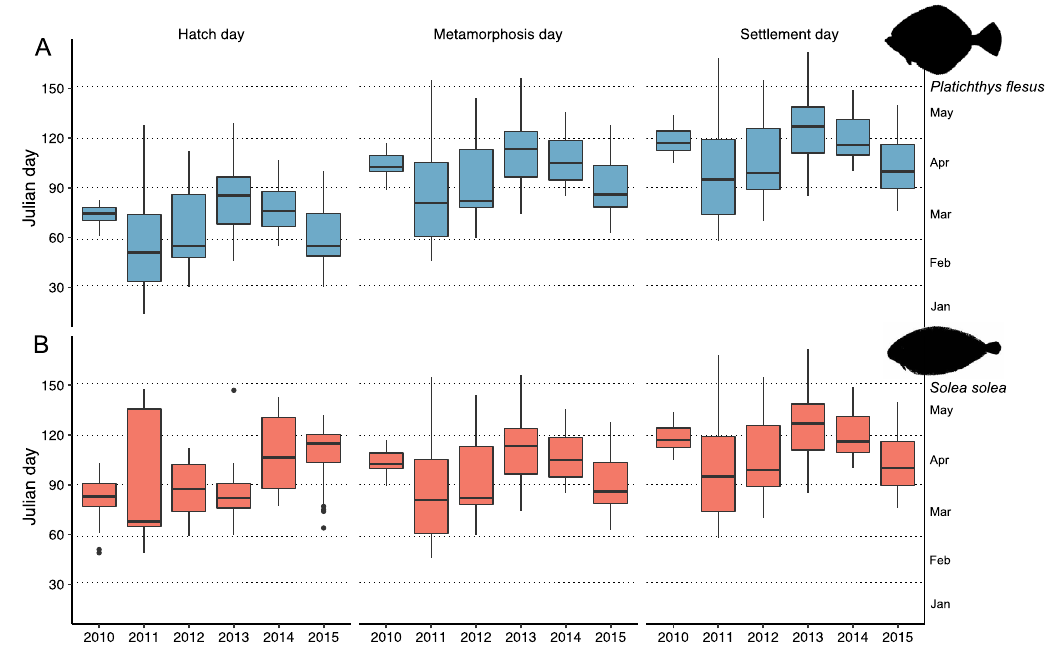
Figure 5. Hatch, metamorphosis, and settlement day distribution boxplots for ( A ) Platichthys flesus and ( B ) Solea solea from 2010 to 2015 (in Julian days). The secondary Y-axis shows the corresponding month. The boxplot horizontal thick lines represent the median value and each box the interquartile range from 25 to 75%. The bars represent the largest value within 1.5 times the interquartile range above the 75th percentile and the smallest below the 25th percentile respectively, and the outliers are represented by the black dots. The secondary Y-axis represent the respective